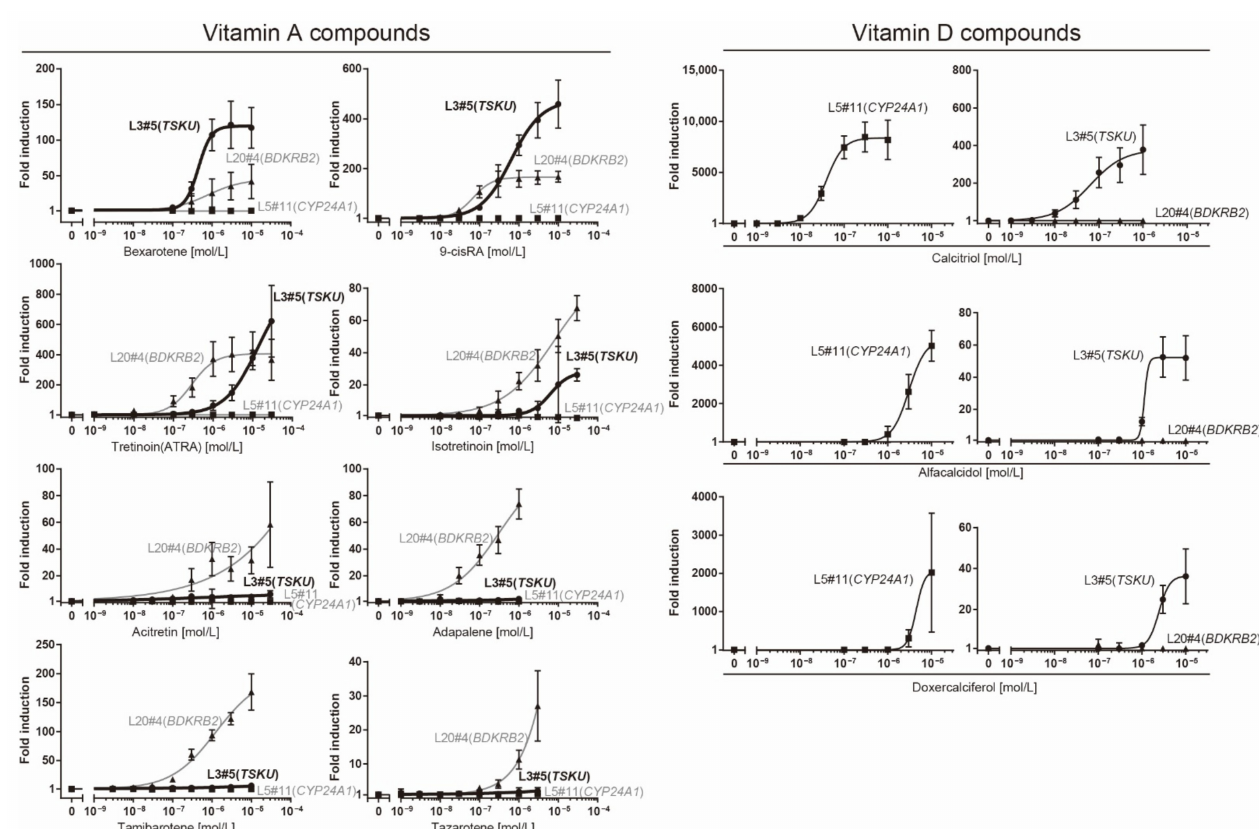
Figure 4. Dose–response analysis of reporter cells (Table 1) against various vitamin analogs using a luciferase assay. The plots are the mean from three independent experiments with three measurements each. Error bars indicate SD. The fold-induction value for 0 M was defined as